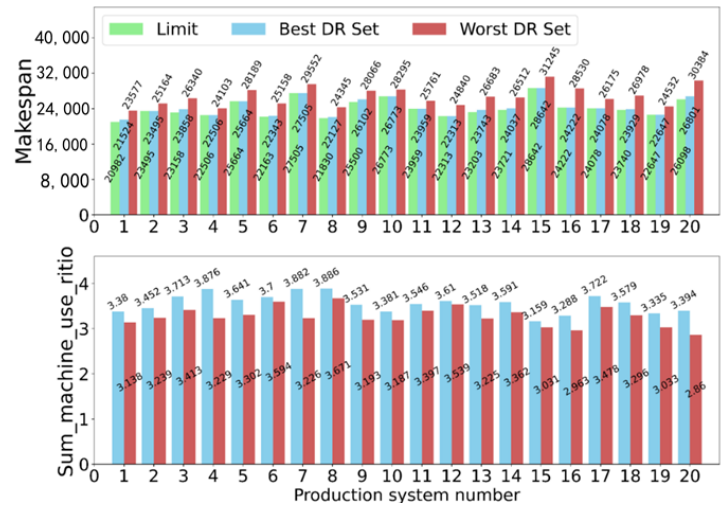
Mathematics 2022 , 10 , x FOR PEER REVIEW Figure 8. High job heterogeneity and a high manufacturing system load rate. Figure 8. High job heterogeneity and a high manufacturing system load rate.